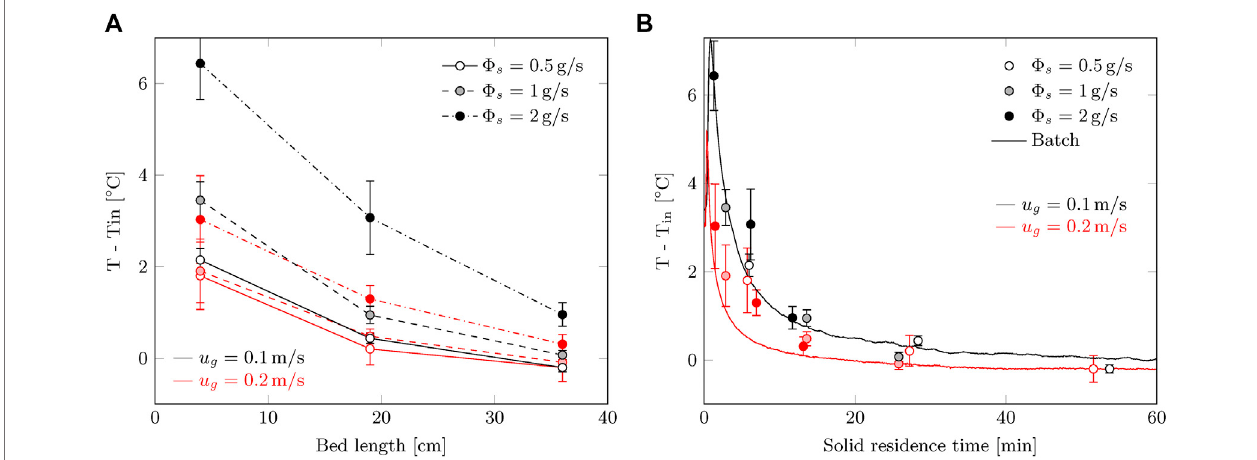
FIGURE 10 | Temperature increase during the steady-state phase of the radial fl ow moving bed experiments as function of: (A) axial location of the contactor (0 (cid:1) top; 40 cm (cid:1) bottom) and (B) solidresidence time (batch process data isadded for comparison). The errormargins represent the standard deviation in the steady-state